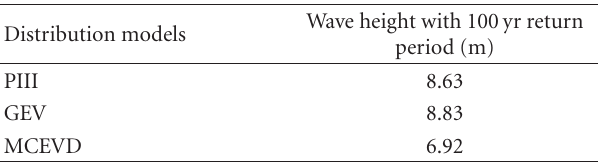
Table 3: Prediction result for wave height by di ff erent probabilistic models.